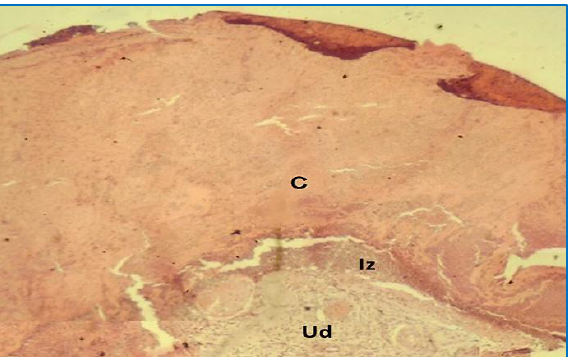
Figure, 11: Magnified section of skin (14 days -control) shows epidermis (E), dermis (D), and blood vessels (Arrows). H and E, 100x.